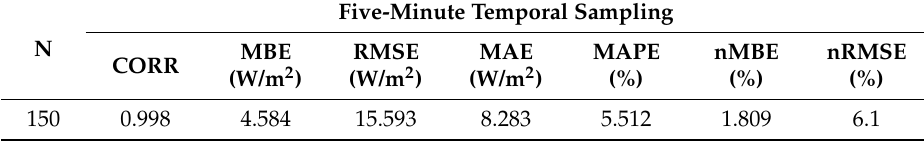
Table 9. Statistical analysis for the five-minute AMESIS temporal sampling product against ground measurements at the JRC (Ispra) site, considering the whole dataset. N = the total number of hourly mean irradiance